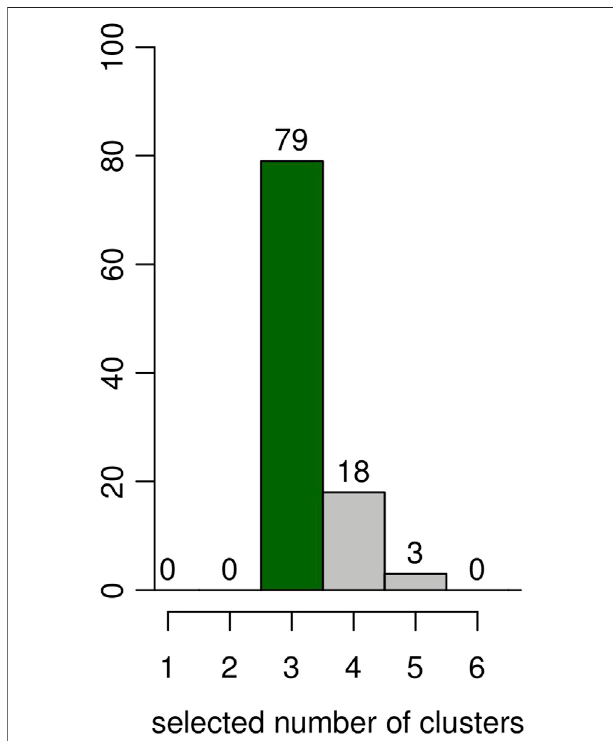
FIGURE 4 | Results on arti fi cial data over 100 simulations. Estimated number of clusters according to the BIC. The y -axis represents the number of simulations for the number of clusters selected in the x